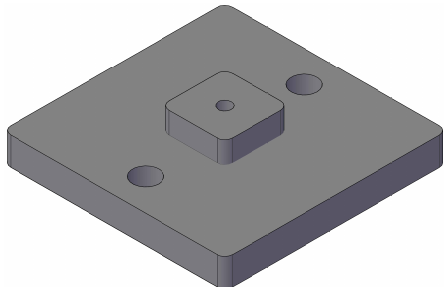
Figure 5. Illustration of the metal 3D-printed copper bodies, used as the substrate for the inkjet-printed capacitive sensor.